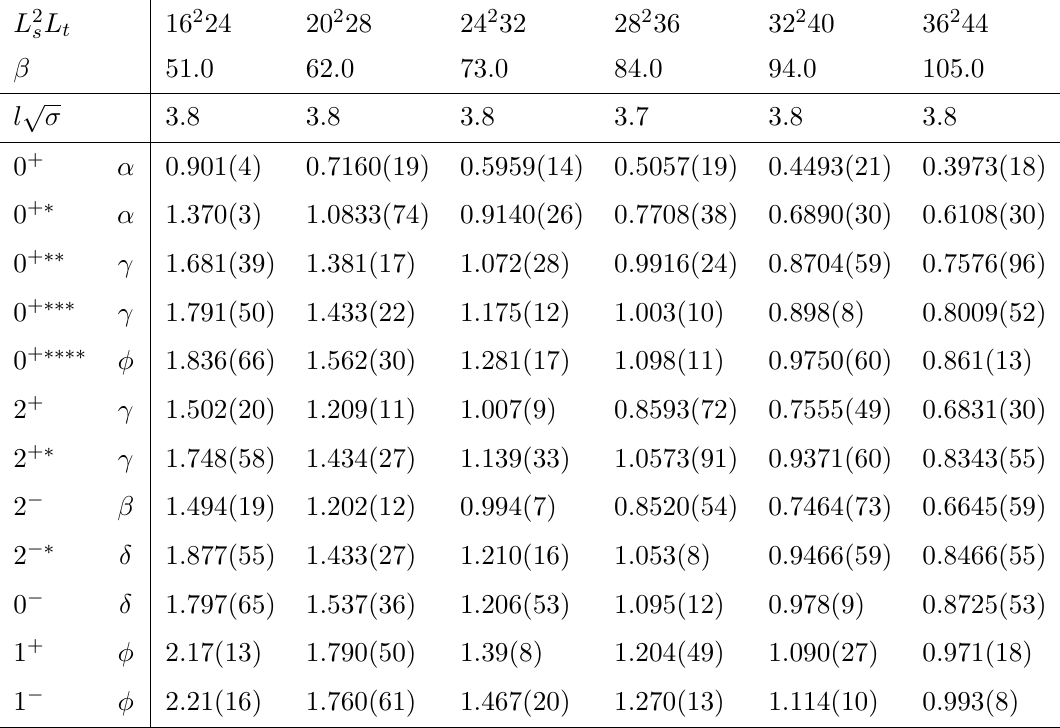
Table 25 . SO(8) glueball masses am G . Grades, e.g. (cid:11) , explained in section 3.6.6.